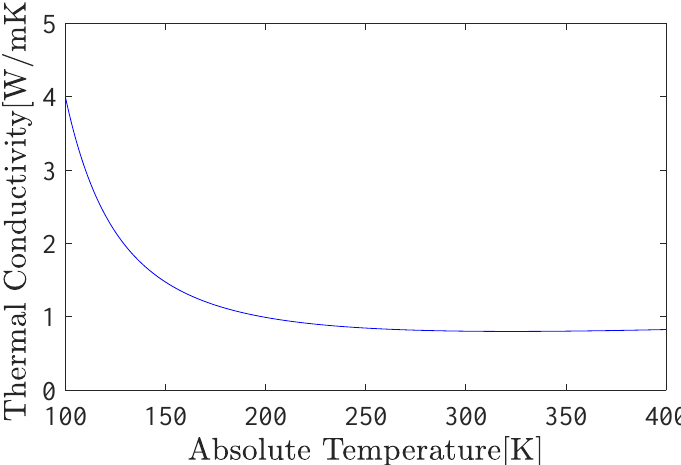
Figure 3. Temperature dependence of thermal conductivity